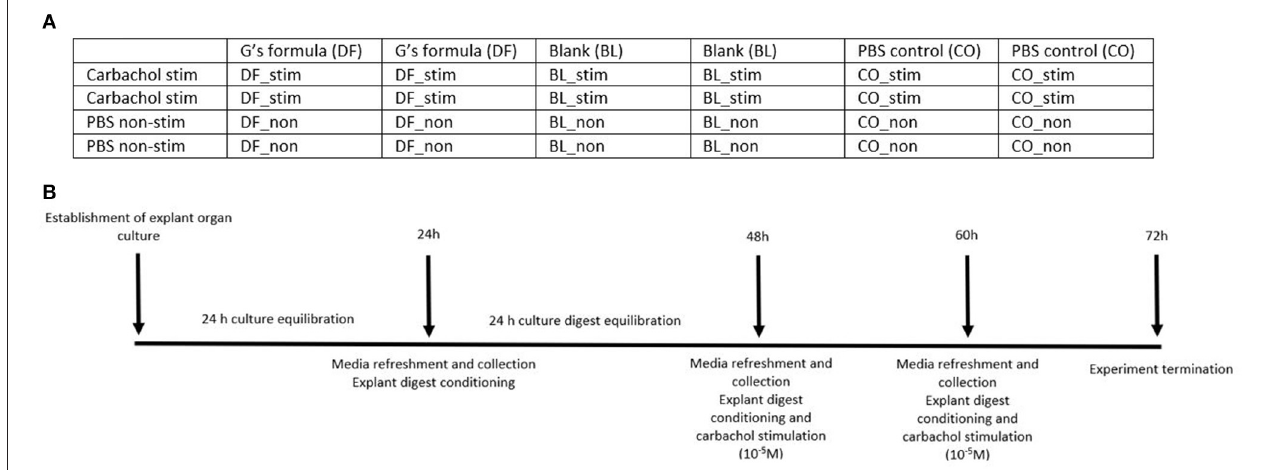
FIGURE 1 | (A) A plate map of the treatments used on a culture plate. BL_non, explants were treated with a blank gastric digest and stimulated with sterile PBS; BL_stim, explants were treated with a blank gastric digest and stimulated with 10 − 5 M carbachol; CO_non, explants were treated with sterile PBS and stimulated with sterile PBS; CO_stim, explants were treated with sterile PBS and stimulated with 10 − 5 M carbachol; DF_non, explants were treated with a gastric digest of the dietary supplement G’s Formula TM , composed of dried cabbage, carrot, hemp, and oat flour, and stimulated with sterile PBS; DF_stim, explants were treated with a gastric digest of the dietary supplement G’s Formula TM composed of dried cabbage, carrot, hemp, and oat flour, and stimulated with 10 − 5 M carbachol. (B) A visual timeline of the experimental